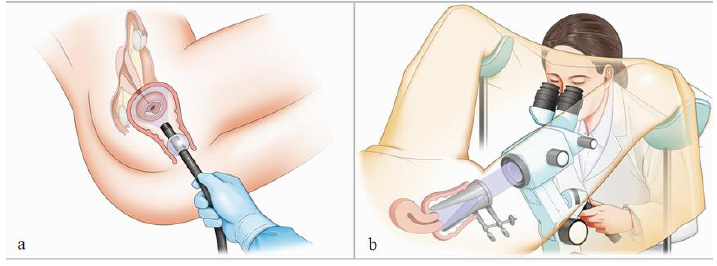
Figure 2. Schematic illustration of patient positioning: ME-NBI ( a ) and colposcopy ( b ).